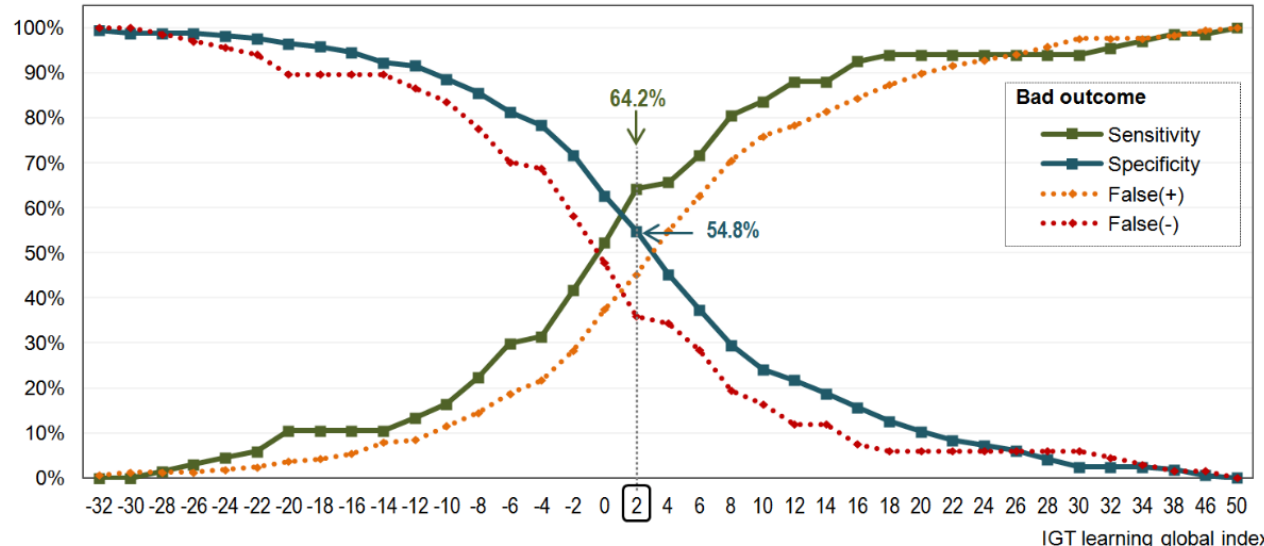
Figure 2. Valuation of the IGT-Learning raw score to predict the treatment outcome. Note. Results obtained for the ED subsample ( n = 233).